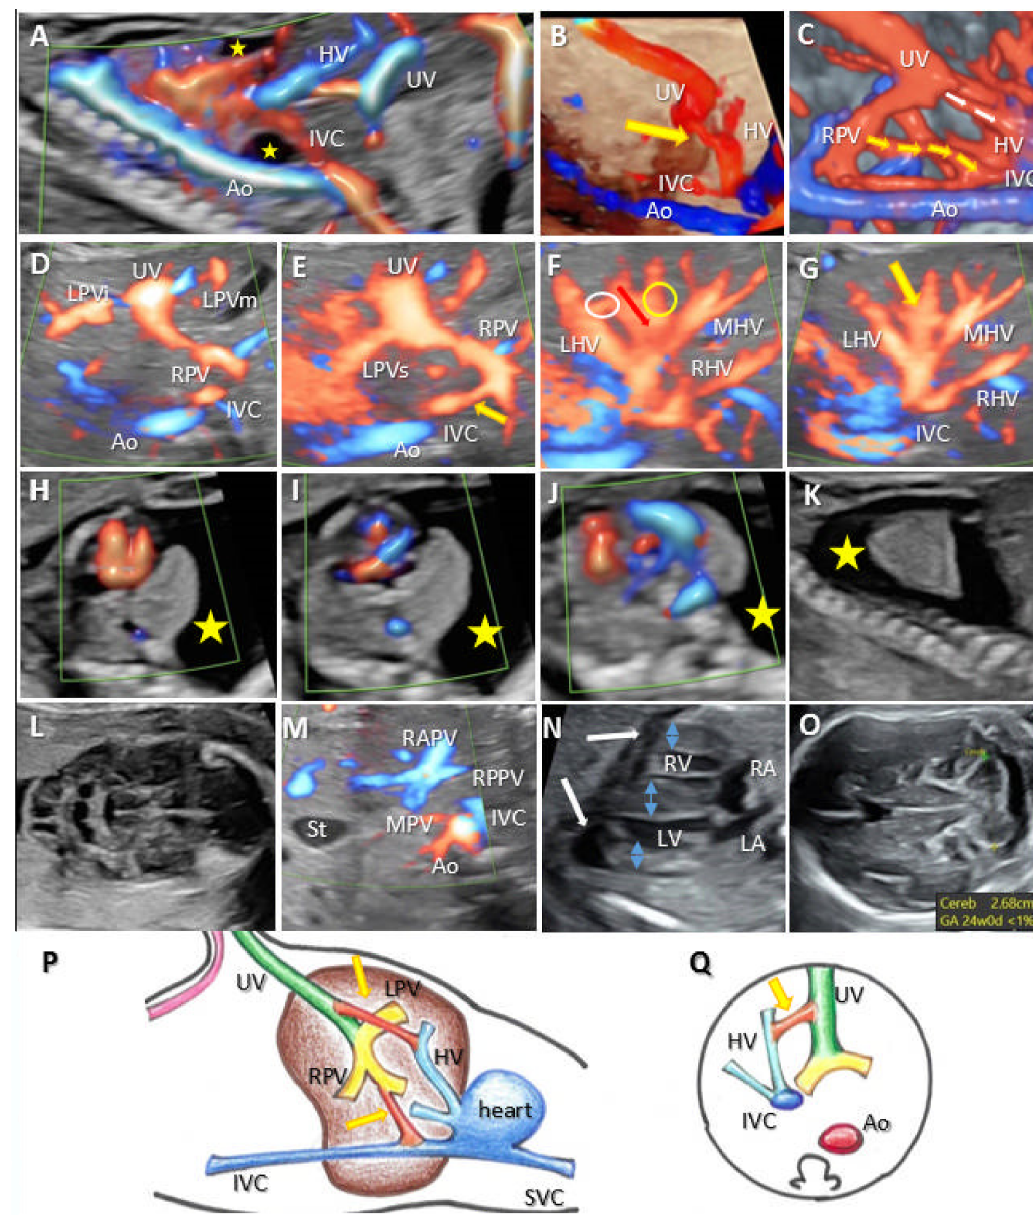
Figure 6. Complex drainage of the umbilical vein (UV) into the hepatic vein (HV) and two other intrahepatic shunts (one between the shunt and the left hepatic vein and the other between the right portal vein and the IVC) at 18 and 28 weeks of gestation (WG) (Case 18). ( A ) Color Doppler assessment at 18 WG showing the drainage of the UV into the middle branch of the HV. ( B ) Four-dimensional STIC rendering showing in the sagittal plane the short shunt vessel (yellow circle) connecting the umbilical and hepatic vein, below the prediaphragmatic infundibulum. ( C ) Four-dimensional STIC rendering showing two abnormal connections: one between the UV and the HV (white arrows) and another between the right portal vein and the IVC (yellow arrows). ( D – G ) Consecutive axial abdominal planes, part of the umbilical–portal and hepatic circulation investigation. ( D ) Caudally, a transverse plane at the level of the portal sinus. ( E ) A connection between the right portal vein and IVC (yellow arrow) is identified in the upper abdomen. ( F ) The white circle highlights a connection between the left hepatic vein and an abnormal shunt between one smaller venous branch of the portal vein (red arrow) and the umbilical vein. ( G ) Axial plane at the level of the hepatic efferent venous system and the umbilical–hepatic shunt (yellow circle). ( H – K ) The four-chamber and outflow tract views along with massive pleural effusion (yellow mark). ( L ) Ultrasound image of septated cystic hygroma at 18 WG. ( M ) Transverse plane at the level of the fetal abdomen with the typical aspect